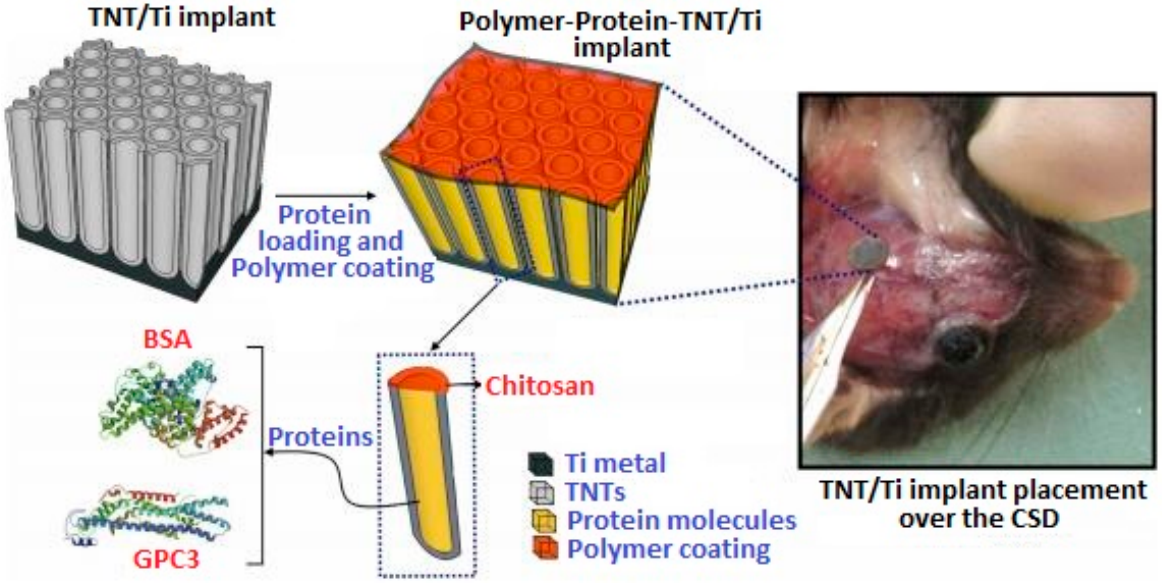
Figure 13. Schematic representation of GPC3 loaded Ti/TNT/chi implant. Reproduced from [133].